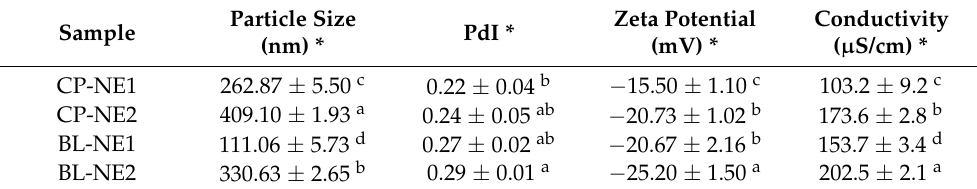
Table 3. Particle size, PdI, zeta potential, and conductivity of CP-NE.